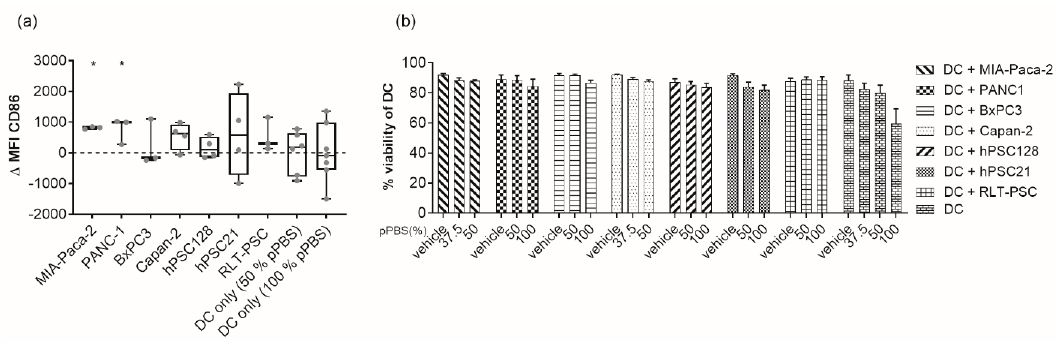
Figure 4. Maturation and viability of DCs after coculture with pPBS-treated PSCs and PCCs. ( a ) Box plot from minimum to maximum value of ∆ MFI of the maturation marker CD86. CD86 expression is examined on immature DCs after 48 h of coculture of pPBS-treated PCCs and PSCs (effector/target (E/T) ratio, 1:1), and after pPBS treatment on immature DCs without coculture using flow cytometry. ∆ MFI represents [(MFI staining treated–MFI isotype treated)–(MFI staining untreated–MFI isotype untreated)]. Treatment of 50% pPBS is used for MIA-Paca-2 and Capan-2, while treatment of 100% pPBS is used for PANC-1, BxPC3, hPSC128, hPSC21, and RLT-PSC. Every dot represents a different healthy donor and ≥ 3 donors were used per cell line. * p < 0.05 significant differences compared with untreated control. ( b ) Percentage of viability of DCs after 48 h coculture with pPBS-treated PCC lines (MIA-Paca-2, PANC-1, BxPC3, Capan-2) and PSC lines (hPSC128, hPSC21, RLT-PSC) or pPBS treatment alone. Graph represent mean of ± SEM of ≥ 3 independent experiments with di ff erent donors. * p <